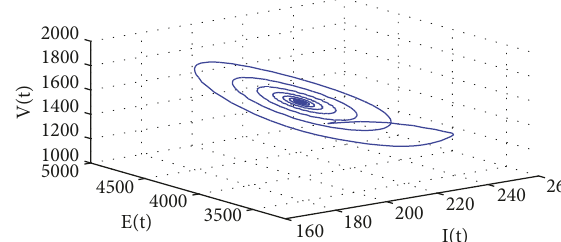
Figure 2: Dynamic behavior of system (35): projection on V-E-I with 𝜏 = 65.85 < 𝜏 0 .